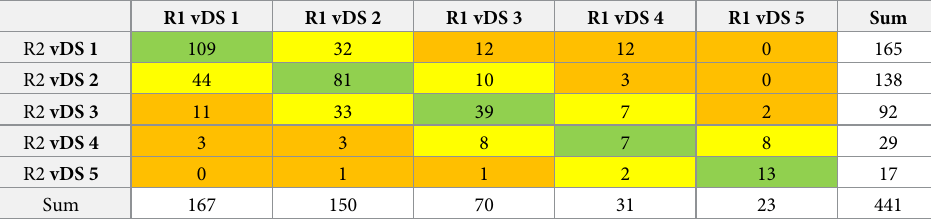
Table 2. Comparison of the visual Deauville scores (vDS) of reader 1 (R1) and reader 2